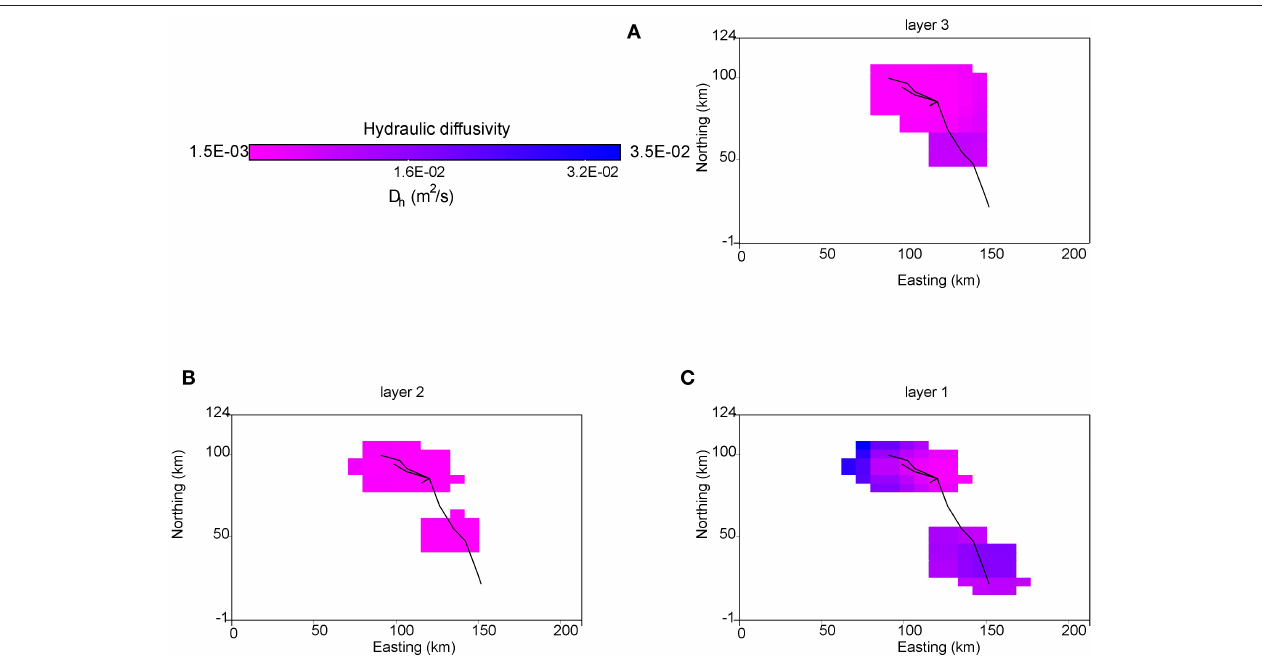
FIGURE 11 | Hydraulic diffusivity tomographic inversion (A) plan view of the diffusivity distribution in the lowermost layer; the pixels with low ray-coverage are masked in white; (B) the same in the intermediate layer; (C) the same in the shallowest layer. Black lines in (A–C) indicate the ray traces. Origin of model:11.8 ◦ E, 45.6 ◦ N.